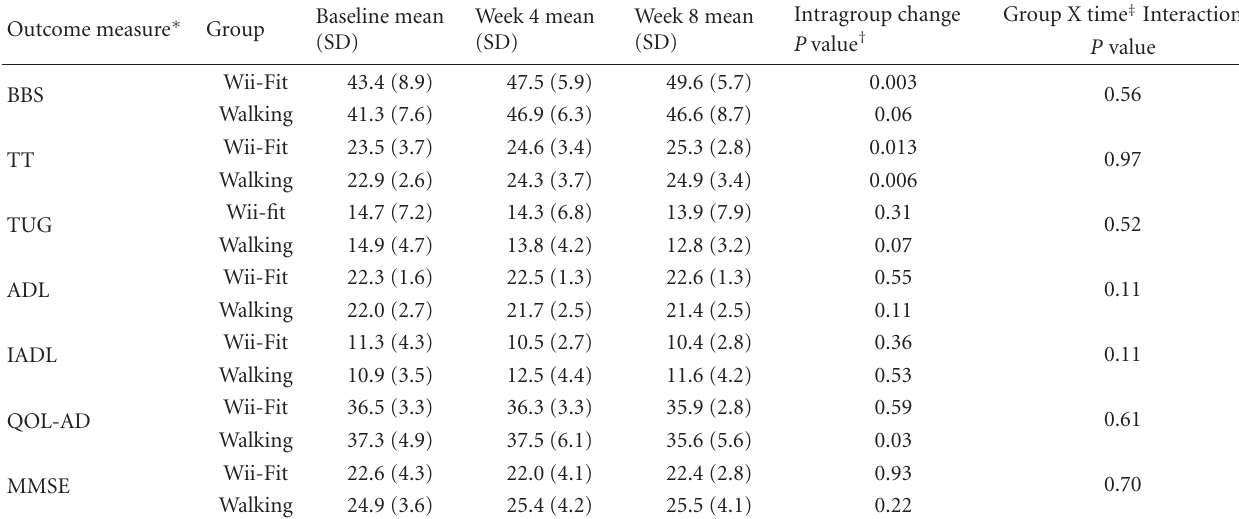
Table 2: The e ff ects of a Wii-Fit and walking interventions on measured outcomes.